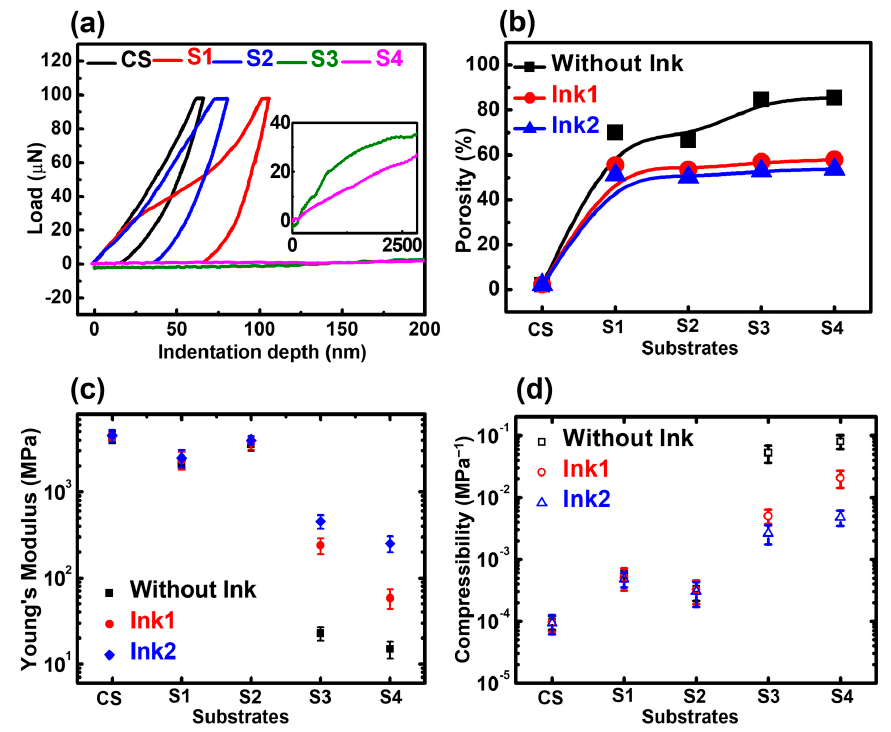
Figure 7. ( a ) Nanoindentation data of our cellulose fiber substrates ( b ) porosity values of cellulose fiber substrates determined by helium pycnometry ( c ) elastic modulus and ( d ) compressibility data of four cellulose fiber substrates and PET control sample (CS) with and without coating of Ink1 and Ink2. Once the porous nature of cellulose fi ber substrates was con fi rmed, the mechanical properties (elastic modulus and compressibility) were investigated by performing the ten- sile stress-strain test. All the samples were cut into 1 cm wide and 5 cm long pieces. They were clamped at both sides in an MTS 42.503 static tensile testing machine and the tensile force was applied until the samples tore at the middle section. The elasticity of substrates with and without inks is presented in Figure 7c. The CS possesses the elasticity of 4332 MPa in a pristine situation, while it has 4409 MPa and 4524 MPa, respectively, with Ink1 and Ink2 coating—implying no major in fl uence over CS’s elasticity. A similar trend was observed for substrate S1 (photocopy paper) and S2 (cover paper), as the value of E was close for the pristine state and coated state. However, a more drastic change in E was ob- served for S3 (lab tissue paper) and S4 (paper towel). At pristine state, the reported values of E for S3 and S4 were 22 MPa and 14 Mpa, which belong to the same range of the elastic modulus of skin (4.6 MPa–22 MPa) [57]. For S3, the value of E increased to 238 MPa after applying Ink1, whereas, for Ink2, the elastic modulus value was reported as 454 MPa. Meanwhile, for S4, the increased elastic modulus values were 58 MPa (Ink1) and 250 MPa (Ink2). Since S3 and S4 had be tt er absorbability, which is contributed to by their highly porous nature as con fi rmed before, their properties also changed drastically after coating with Ink1 and Ink2.